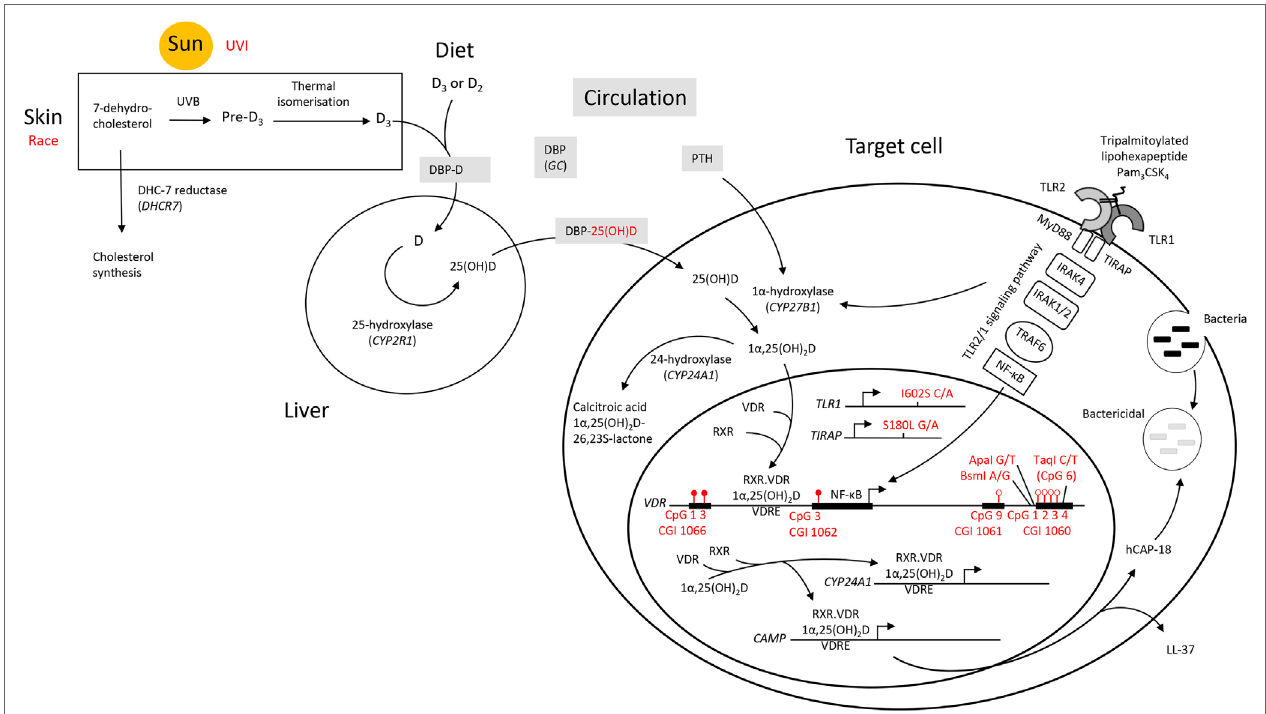
FigUre 8 | A schematic diagram summarizing factors influencing the signaling efficacy of the TLR2/1-VDR pathway in response to TLR2/1 elicitation. Pam 3 CSK 4 (Pam 3 CysSerLys 4 ), a synthetic tripalmitoylated lipopeptide, mimics the acylated amino terminus of bacterial lipoproteins and is recognized by TLR2, cooperating with TLR1 to induce signaling that activates the pro-inflammatory transcription factor NF- κ B, inducing CYP27B1 and VDR . Factors found to influence VDR expression are indicated in red. UVI correlated with 25(OH)D 3 , known to autoregulate VDR . Individuals who responded with an above average level of VDR protein upon TLR2/1 elicitation were hypermethylated at CGI 1066 (CpG 1 and 3) and CGI 1062 (CpG 3), while hypomethylated at CGI 1061 (CpG 9) and CGI 1060 (CpG 1–4). With in vitro 1,25(OH) 2 D 3 supplementation CGI 1062 CpG 3 was slightly less discriminatory upon TLR2/1 elicitation, but remained a significant variable to discriminate above/below average VDR protein level. However, with supplementation the population clustered by race and all genetic variants indicated ( TLR1 SNP I602S, TIRAP SNP S180L, and VDR SNPs Bsm I, Apa I, and Taq I, see Table 4 ), compared to clustering by vitamin D status and Taq I alone, without supplementation. Methylation at CpG 6 of CGI 1060 (dictated by Taq I, with which it overlaps) together with UVI and circulating 25(OH)D 3 , significantly discriminated a 1.2-1.5-fold change in VDR mRNA with supplement or elicitation. Abbreviations: CAMP , cathelicidin antimicrobial peptide; CGI, CpG island; CpG, cytosine-phosphate-guanine dinucleotide; CYP, cytochrome P-450 enzyme; CYP24A1 , 25-hydroxyvitamin D 3 -24-hydroxylase; D 2 , ergocalciferol; D 3 , cholecalciferol; DBP, vitamin D binding protein; GC , group component or gene encoding DBP; hCAP-18, human cathelicidin antimicrobial peptide 18; LL-37, cathelicidin antimicrobial peptide fragment; 1,25(OH) 2 D 3 1,25-dihydroxycholecalciferol; 25(OH)D 3 , 25-hydroxycholecalciferol; NF- κ B, nuclear factor kappa B; Pam 3 CSK 4 , synthetic tripalmitoylated lipohexapeptide, PTH parathyroid hormone; RXR retinoid X receptor; TIRAP , TIR, toll-interleukin 1 receptor domain-containing adaptor protein; TLR, toll-like receptor; UVB, ultraviolet B rays; UVI, ultraviolet index; VDR , vitamin D receptor gene; VDR, vitamin D receptor protein; VDRE, vitamin D receptor